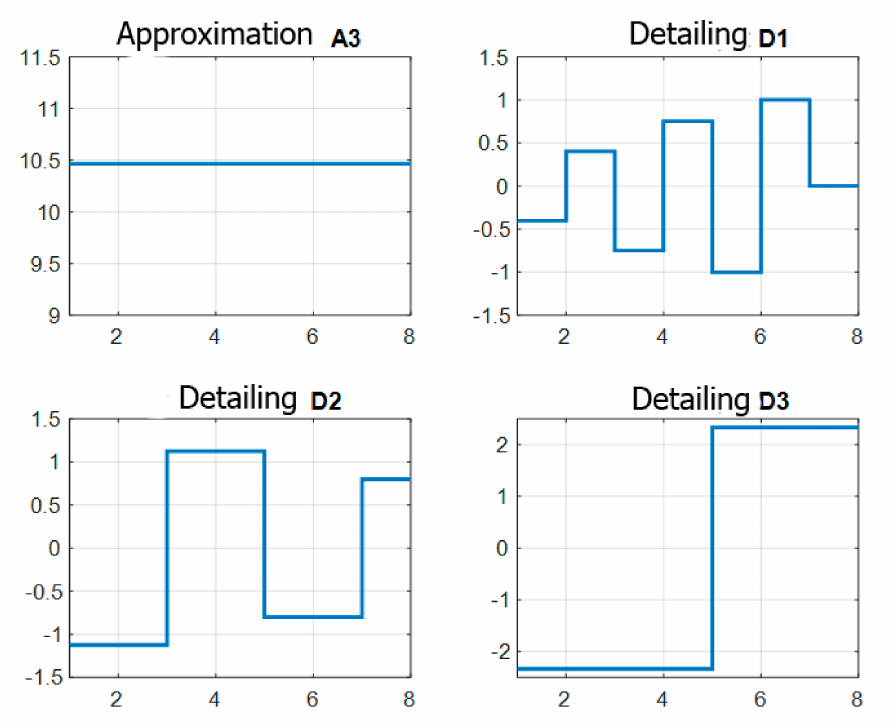
Figure 2. Three-level wavelet-decomposition of y vector based on the ‘db1’ wavelet. The values of the elements of the y vector in the group are equal to x, v, z, t. Then,